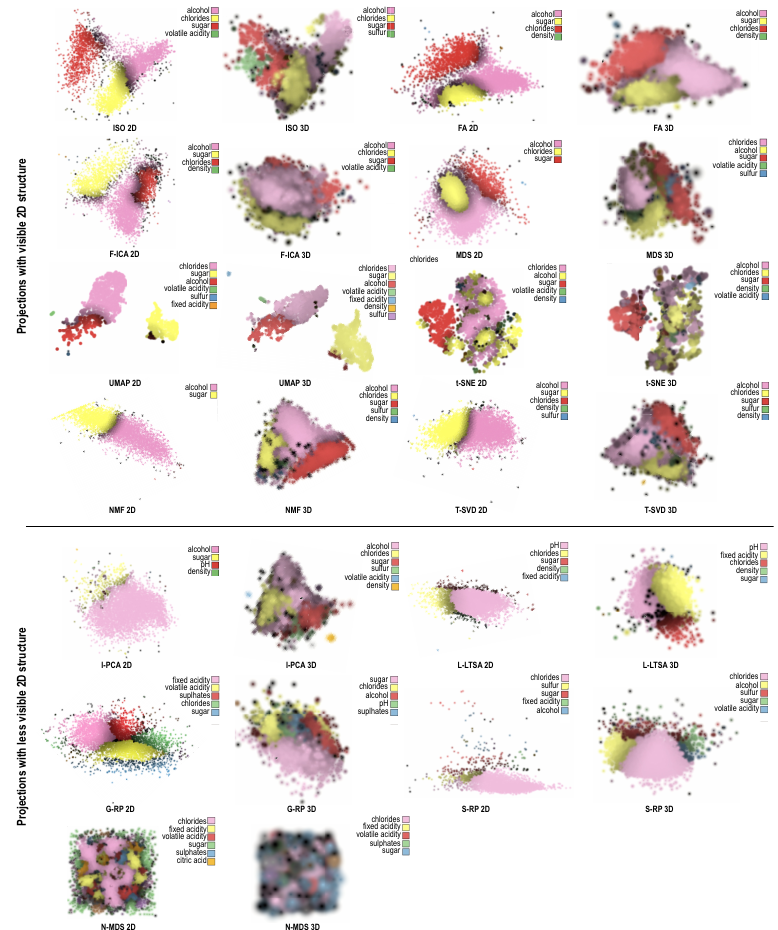
Figure 4. Comparison of 2D and 3D projections explained by dimension variance, Wine dataset. Dimension-to-color mapping is computed per individual projection (Section